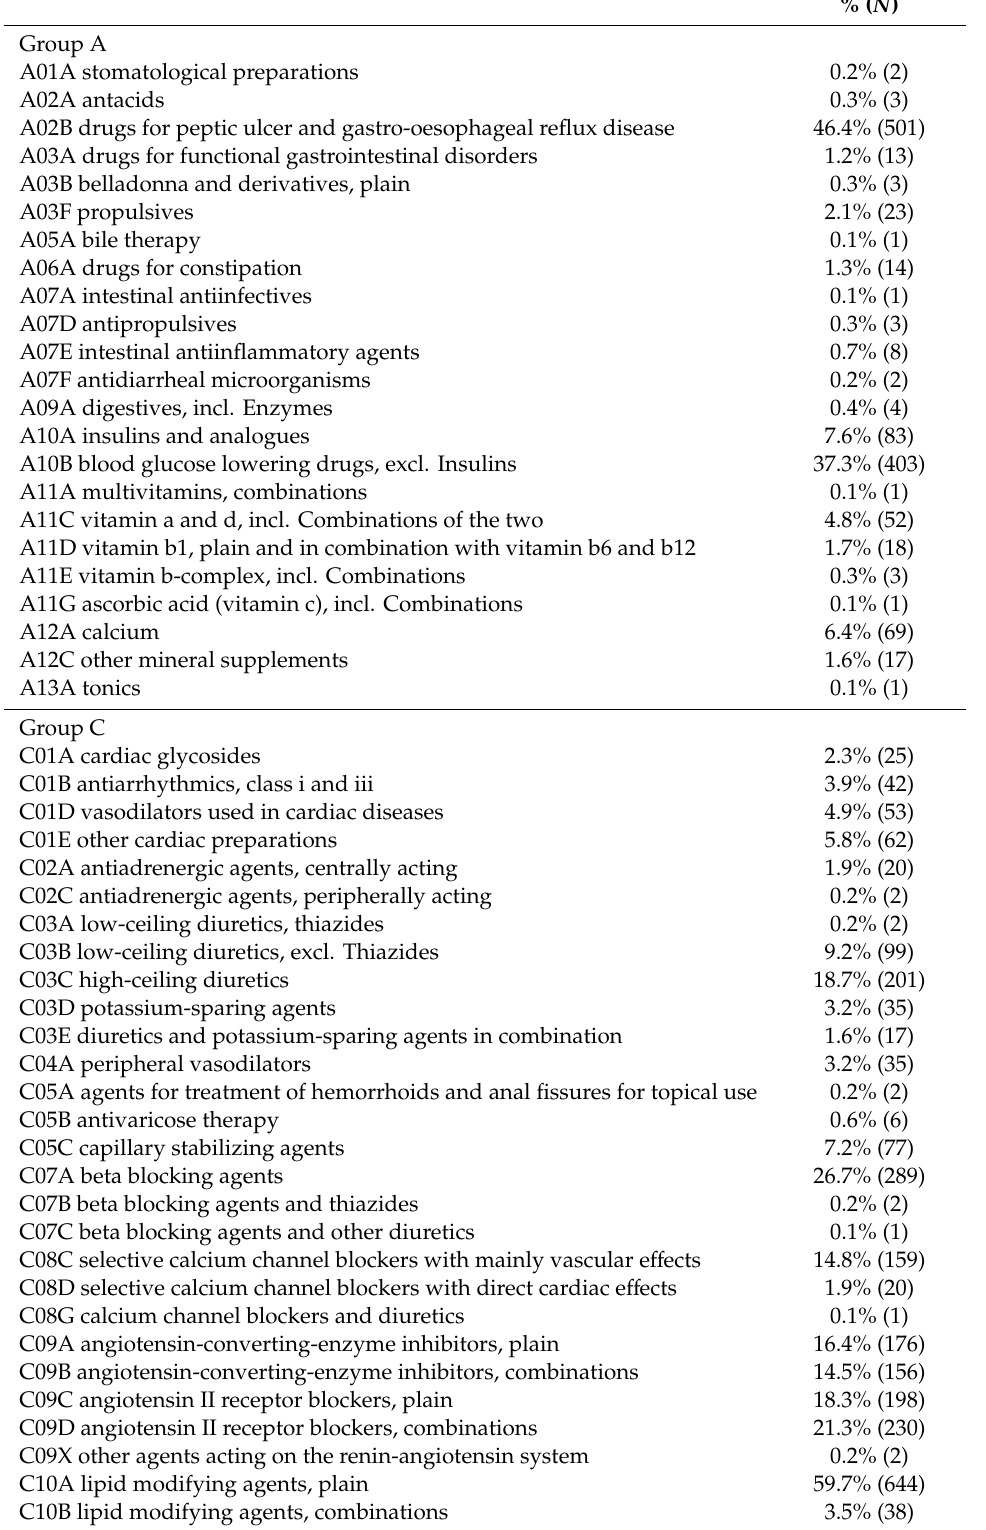
Table 2. Consumption of medicines from the fourth level pharmacological groups of Group A, Group C, and Group